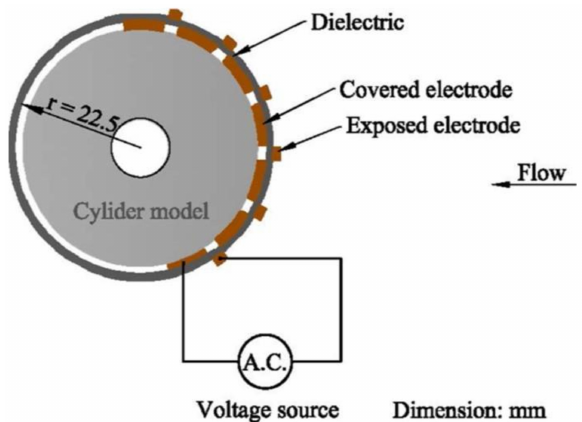
Figure 11. Multi-actuator configuration (adapted from Cai et al. [29] on with the permission of Springer).